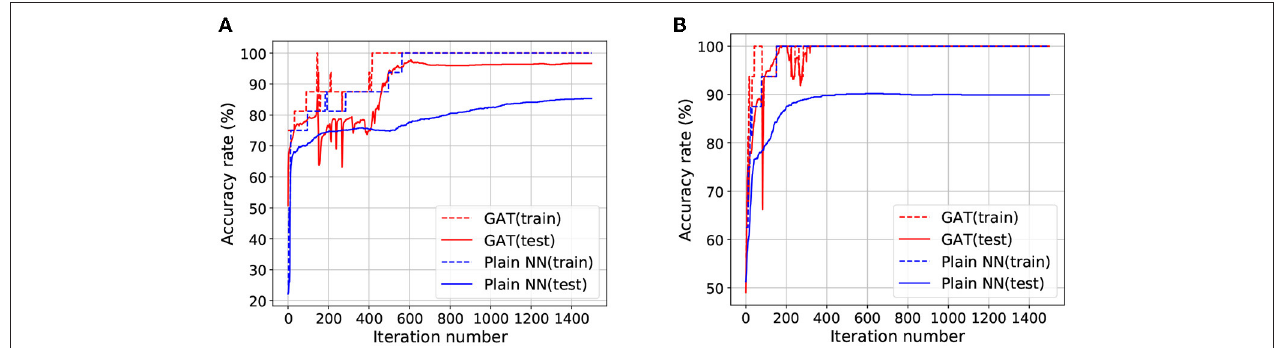
FIGURE 2 | The transition curves of accuracy rates by Plain NN and the proposed GAT on M -dataset and C -dataset. (A) Plots the results for M -dataset, (B) plots the results for C -dataset.